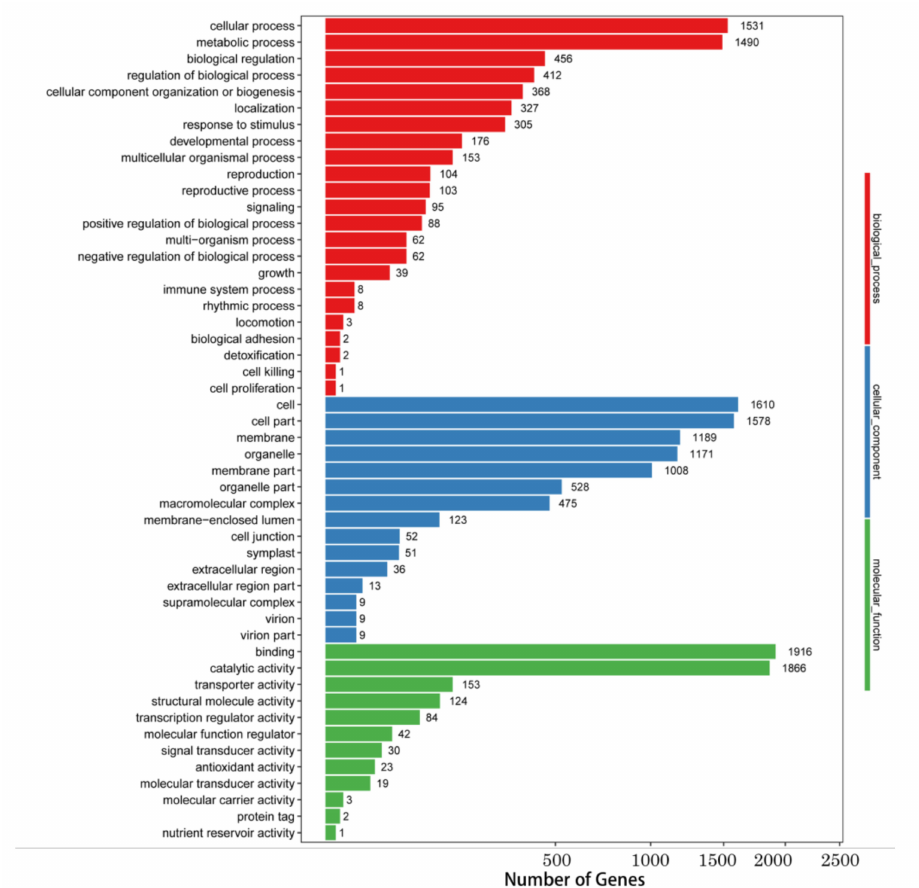
Figure 2. Gene ontology (GO) classifications of differentially expressed Unigenes. Unigenes were assigned to three categories: Biological processes, cellular components, and molecular functions.